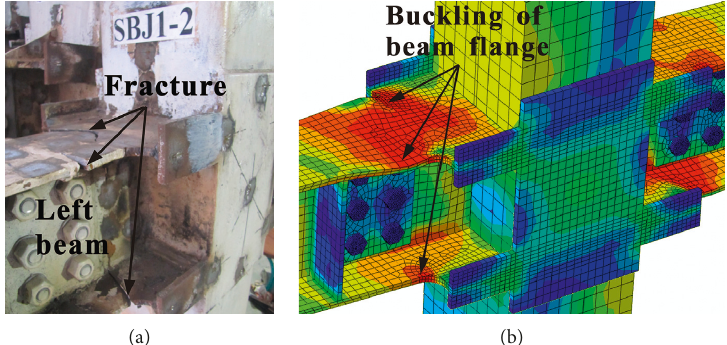
Figure 11: Comparison of the failure modes of the SBJ1-2 specimen determined by test and FEA. (a) Test. (b) FEA.